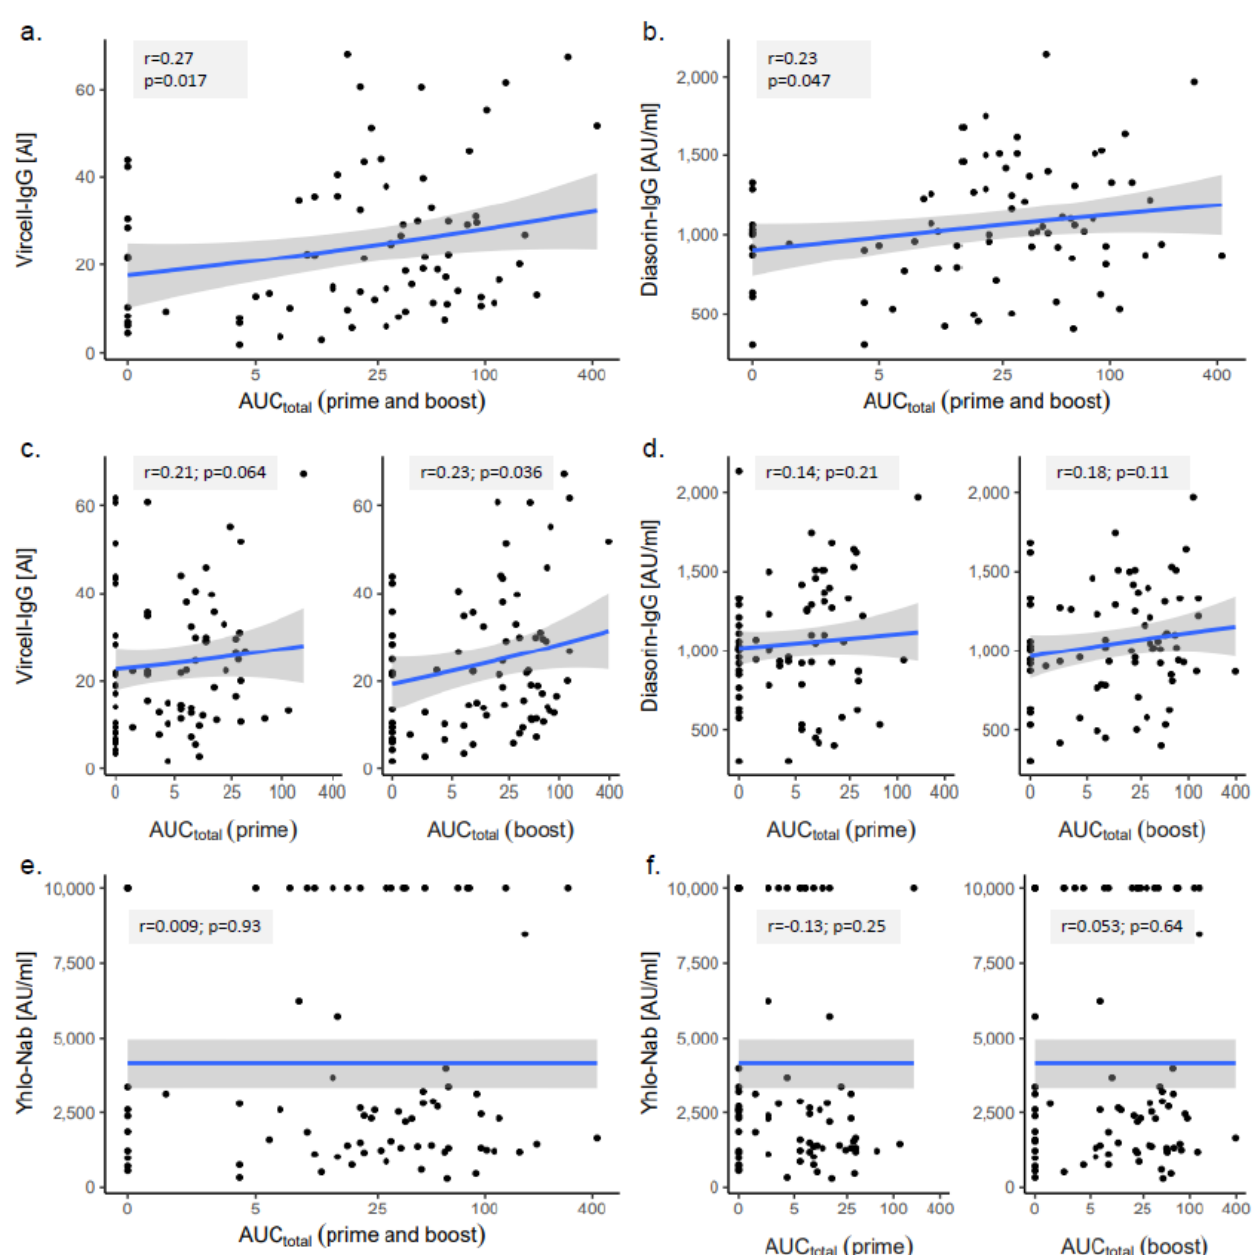
Figure 2. Correlation analysis of the total adverse effect burden (AUC total ) and antibody levels measured with ( a , c ) Vircell- IgG, ( b , d ) DiaSorin-IgG and ( e , f ) Yhlo-NAb. r, Pearson’s correlation coefficient.